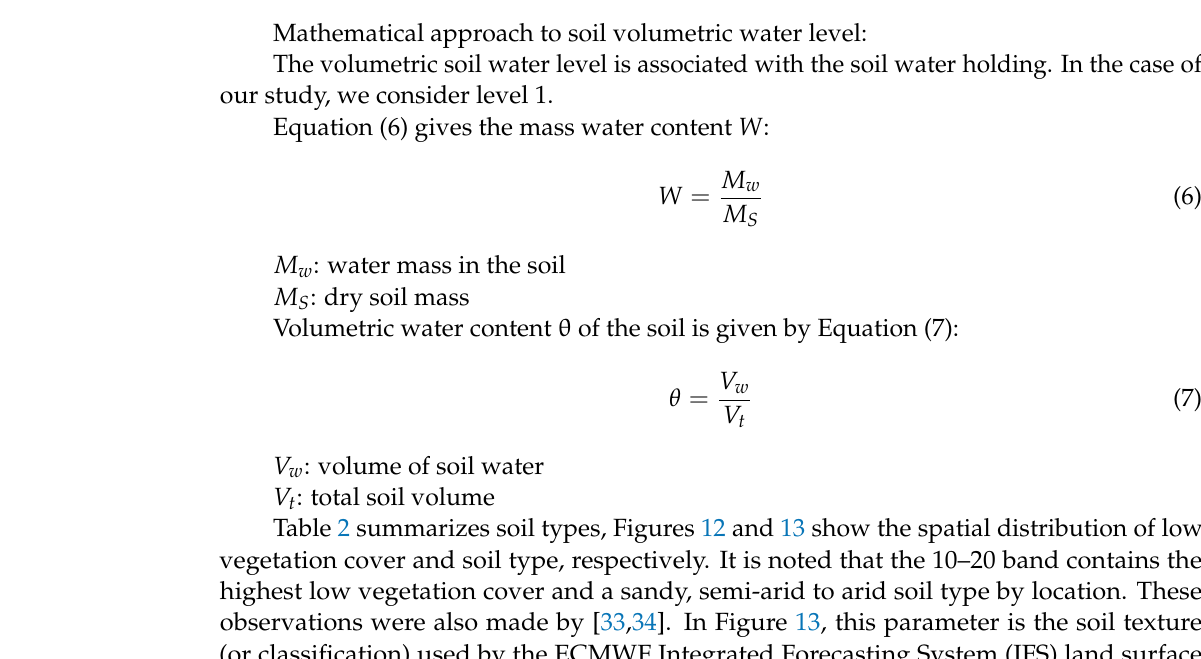
Table 2. Summary of soil types in the 10–20 African band.